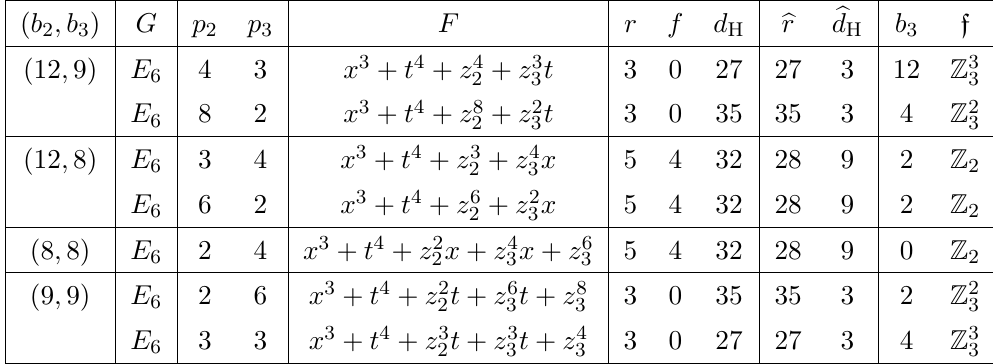
Table 17 . Sporadic models for G = E 6 . Note that there are no solutions with ( b 2 , b 3 ) = (8 , 9) , and the two solutions for ( b ) = (12 , 8) are the same. 2 , b 3